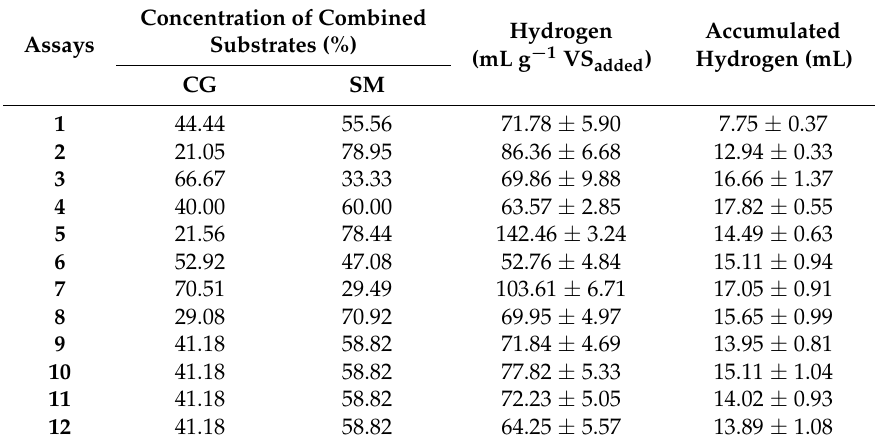
Table 4. Final parameters from the fermentative process, carried out on assays with different concentrations of crude glycerol and swine manure.